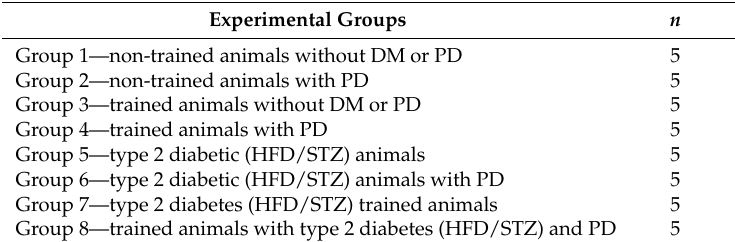
DM—diabetes mellitus induced by high fat diet and one single intraperitoneal injection of streptozotocin (35 mg/kg). PD—Periodontal disease induced by ligature in both mandibular first molars. HFD/STZ—Diabetes induction by High Fat Diet/Streptozotocin. n —Number of rats per